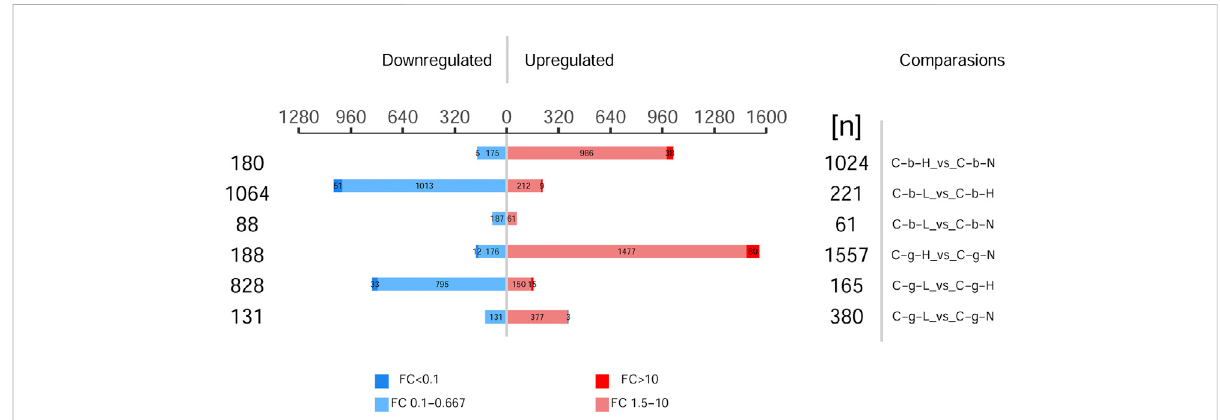
FIGURE 5 Histogram of differentially expressed proteins among different tissues and temperatures. Note: C_b_N represents brain tissues at 22 ° C, C_b_L represents brain tissues at 4 ° C, C_b_H represents brain tissues at 30 ° C; C_g_N represents gill tissues at 22 ° C, C_g_L represents gill tissues at 4 ° C, C_g_H represents gill tissues at 30 ° C. Comparisons represents difference comparison groups (Treat vs. Control). Upregulated represents Up- regulation of differentially expressed proteins. Downregulated represents Down-regulation of differentially expressed proteins. FC represents fold change. p < 0.05.